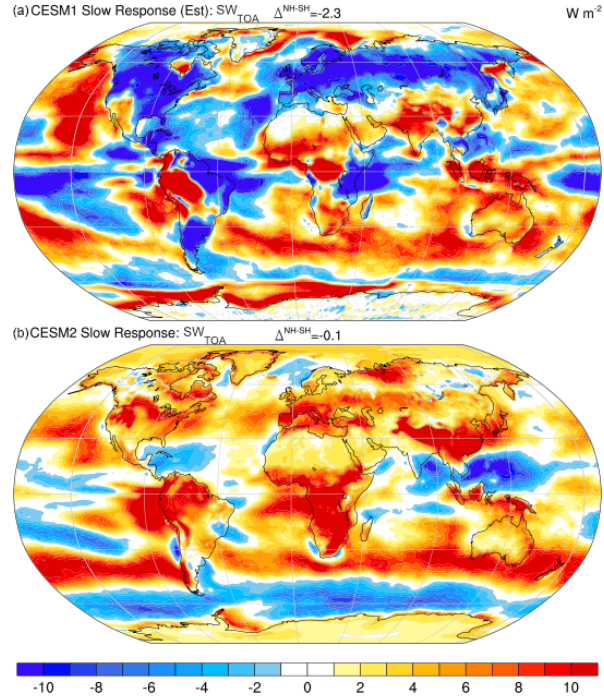
Figure A4. Slow responses of net absorbed TOA solar radi- ation (Wm − 2 ) to CO 2 estimated from abrupt4 × CO 2 simula- tions in CESM1 (a) and computed directly from AMIP + 4K- AMIP simulation differences in CESM2 (b) . The hemispheric con- trasts are large for CESM1 ( − 2 . 3Wm − 2 ) and small for CESM2 (0.1Wm − 2